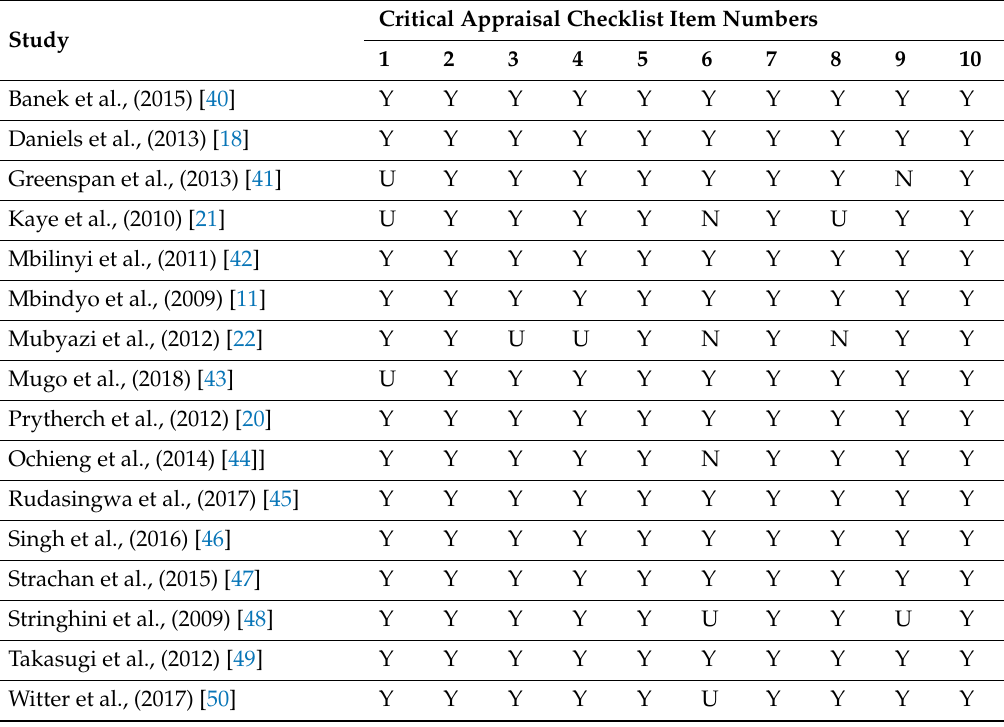
Table 5. Methodological quality of qualitative studies